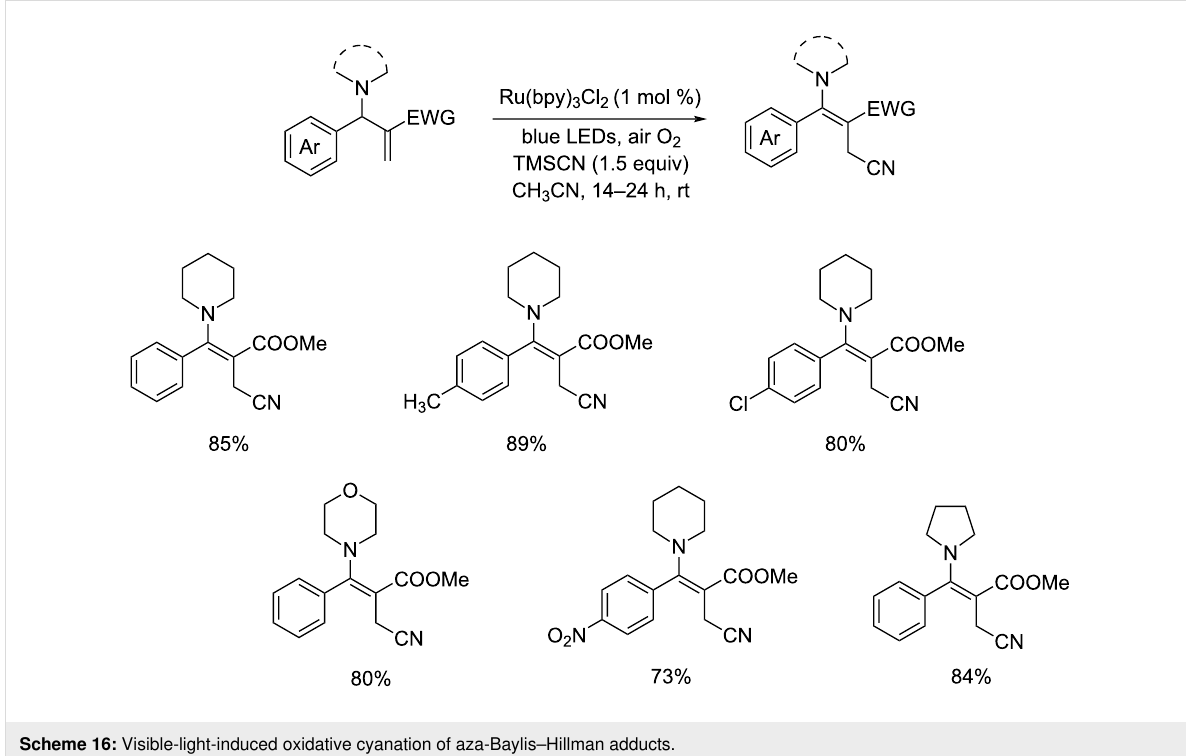
Scheme 16: Visible-light-induced oxidative cyanation of aza-Baylis–Hillman adducts.